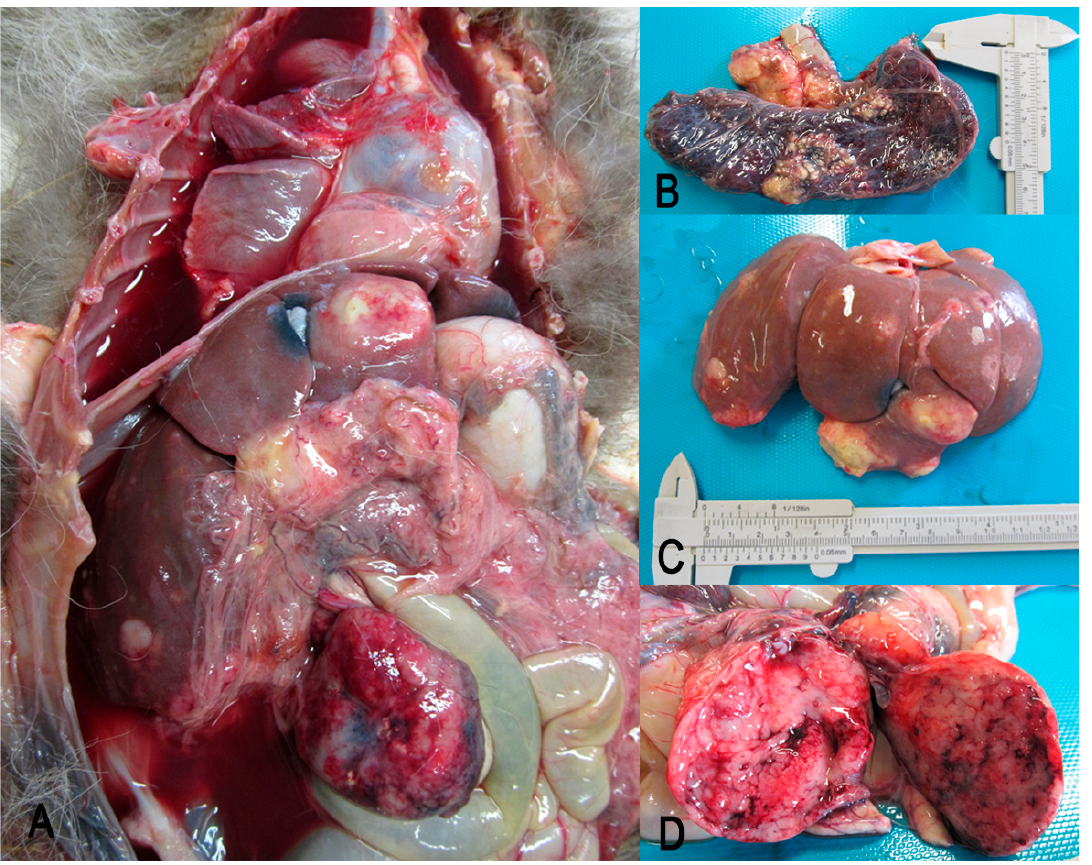
Figure 1. Gross findings. ( A ) Overall macroscopic features of abdominal and thoracic viscera at necropsy. ( B ) Spleen is expanded by white tan nodules, multifocal to coalescing. ( C ) Liver is increased in volume and is characterized by multiple raised white nodules. ( D ) Enlarged mesenteric lymph with a tan light-pinkish cut